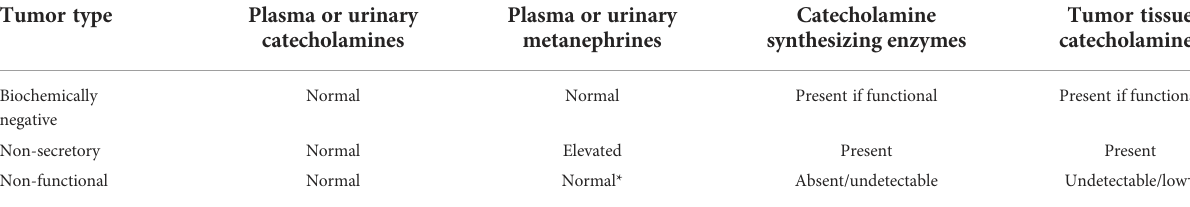
TABLE 3 Expected biochemical test results and features in biochemically negative, non-secretory and non-functional